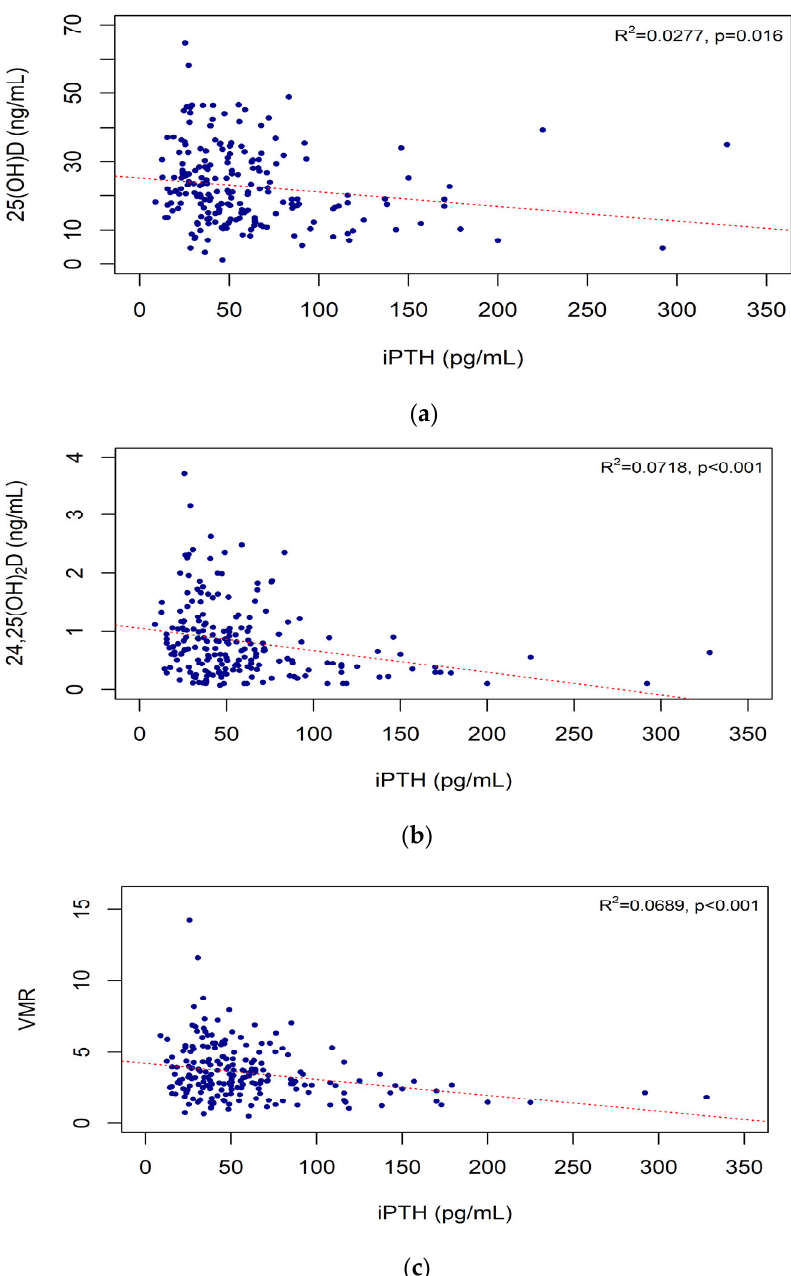
Figure 2. Correlations of intact PTH with vitamin D markers: iPTH and 25(OH)D ( a ), iPTH and 24,25(OH)2D ( b ), and iPTH and VMR ( c ). Abbreviations: iPTH, intact parathyroid hormone; VMR, vitamin D metabolites ratio; 25(OH)D, 25-hydroxy vitamin D; 24,25(OH) 2 D, 24,25-dihydroxy vitamin D.